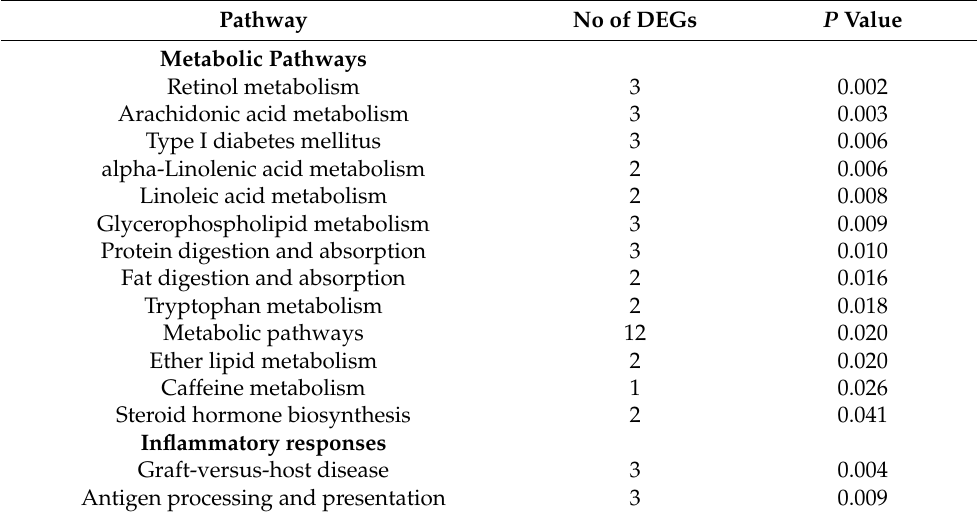
Table A4. KEGG enriched pathway (down-regulated DEGs from Naive control vs.